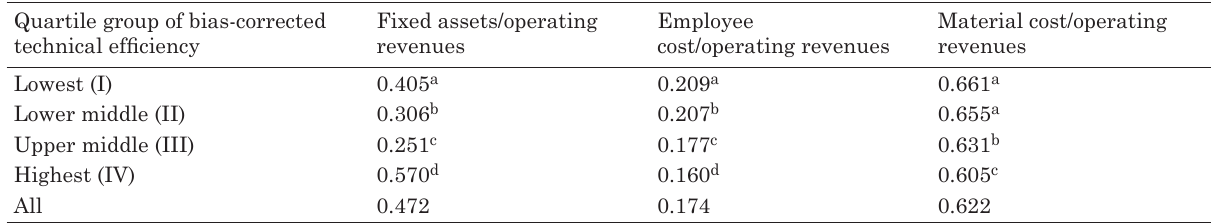
Table 4. Input-Output ratios by quartile groups of bias-corrected technical efficiency scores Quartile group of bias-corrected technical